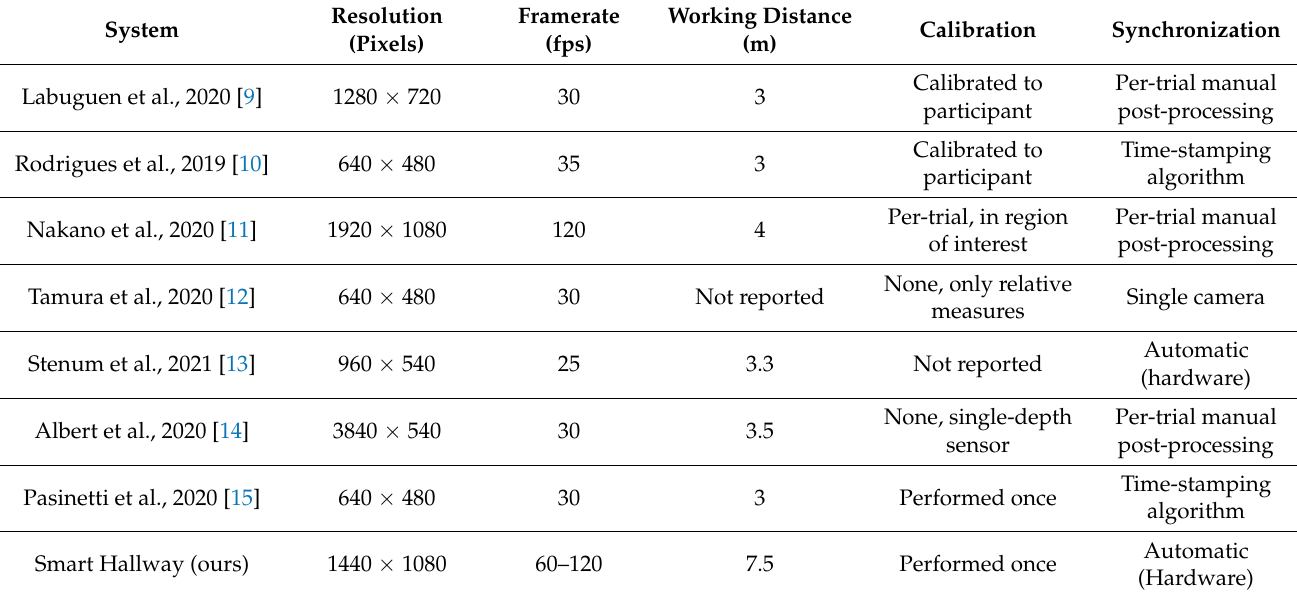
Table 1. Comparison of the Smart Hallway to existing marker-less motion-capture